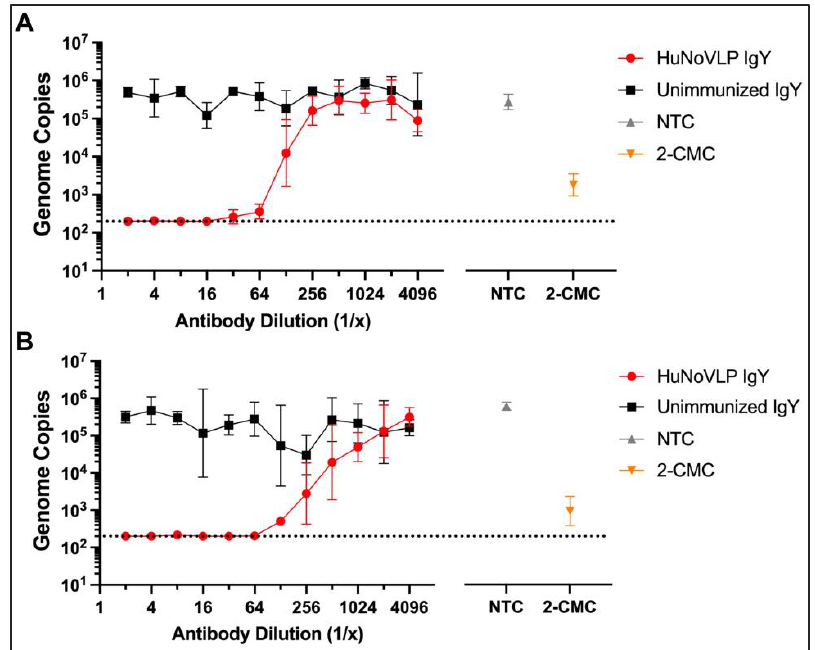
Figure 2. Comparison of neutralization activities of immunized (HuNoVLP IgY) and unimmunized IgY against two isolates ( A ) AB2 and ( B ) 3241SK of HuNoV GII.4 in J2 HIE cells (geometric mean with 95% confidence intervals) showing pooled results of two independent experiments ( N = 8 total replicates per treatment condition). Antibodies were prepared in serial 2-fold dilutions. 2-CMC (2 ′ -C-methylcytidine), a small-molecule viral polymerase inhibitor [39] was used as a positive drug control and tested at a concentration of 200 µM. NTC: non-treatment control for virus growth in the cells (medium alone + virus). Dashed line indicates RT-qPCR limit of detection (2 × 10 2 genome copies per reaction).